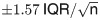
Analysis of relationship structures between features and Cell Speed.(A) A Venn diagram summarizes the frequencies of particular relationship structures between features and changing values of Cell Speed. Each circle of the Venn diagram contains two colors, indicating the Cell Speed quintiles (red, slow; yellow, moderate; green, fast) between which feature values were compared via pairwise testing (slow versus moderate; moderate versus fast; slow versus fast). Segments of the Venn diagram indicate which combinations of pairwise tests (Wilcoxon rank sum test with Bonferroni correction) resulted in statistically discernable differences. The number of features is indicated for which a given combination of tests showed significance. To aid interpretation, schematic archetypes are included to indicate the type of correspondence that is observed between each feature and Cell Speed. Where boxes do not overlap in the Y-axis, statistically significant differences were detected between feature values in the corresponding Cell Speed groups. Note that the actual sign of feature responses may be inverted compared to these generalized archetypes. (B-K) The observed archetypes from (A) are illustrated to the left and examples of features corresponding to each archetype are shown in boxes to the right. Comparison brackets in each panel indicate significant differences (P<0.001 after Bonferroni correction, see Materials and Methods). Box plots show quartiles. Outliers are not shown. Notches are placed at the median value ±1.57 IQR/n, where n is the number of observations in each quintile (approximation of the 95% confidence interval of the median). (B) Mean Cell-Matrix Adhesion Complex (CMAC) Lifetime and (C) median of CMAC Mean paxillin intensity per cell both show stably monotonic decreases across all Cell Speeds. (D) Quartile dispersion (QD) of CMAC compactness is significantly lower in fast than in slow cells. (E) The median rate of change in CMAC area is negative meaning that CMACs are shrinking. This shrinking is more rapid in fast than in slow cells. (F) Cell major Axis is significantly higher in moderate than in slow cell observations, but not between any other groups. (G) QD of CMAC to cell border distance at each time point increases significantly between slow and moderate but not between moderate and fast cells; (H) paxillin-actin colocalization on a cell level decreases in a corresponding way. (I) Coefficient of variation (CoV) of CMAC Speed is significantly lower in fast than in moderate cell observations. (J) The number of CMACs per cell at each time point and (K) the total area of the cell at each time point both show a monotonic decrease between moderate and fast cells.